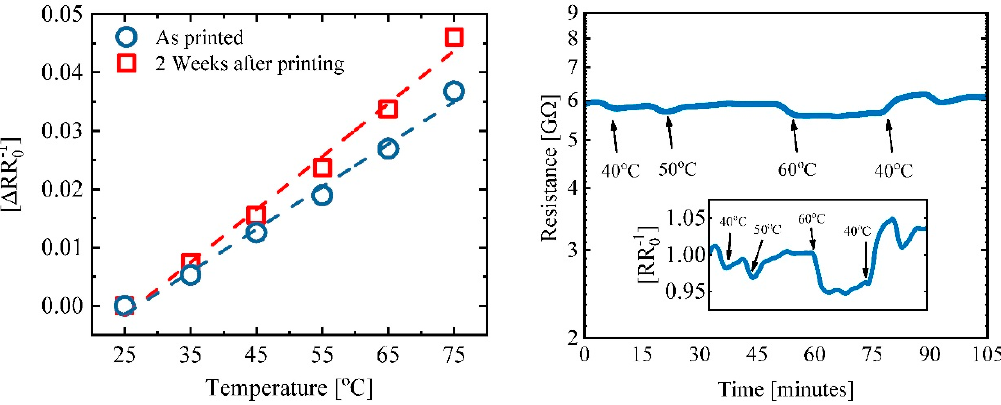
Figure 3. Temperature experiments: ( a ) Temperature response of freshly printed temperature sensor (blue) and 2 weeks after printing (red); ( b ) Resistance of humidity sensor under different temperatures. Inset plot: normalized